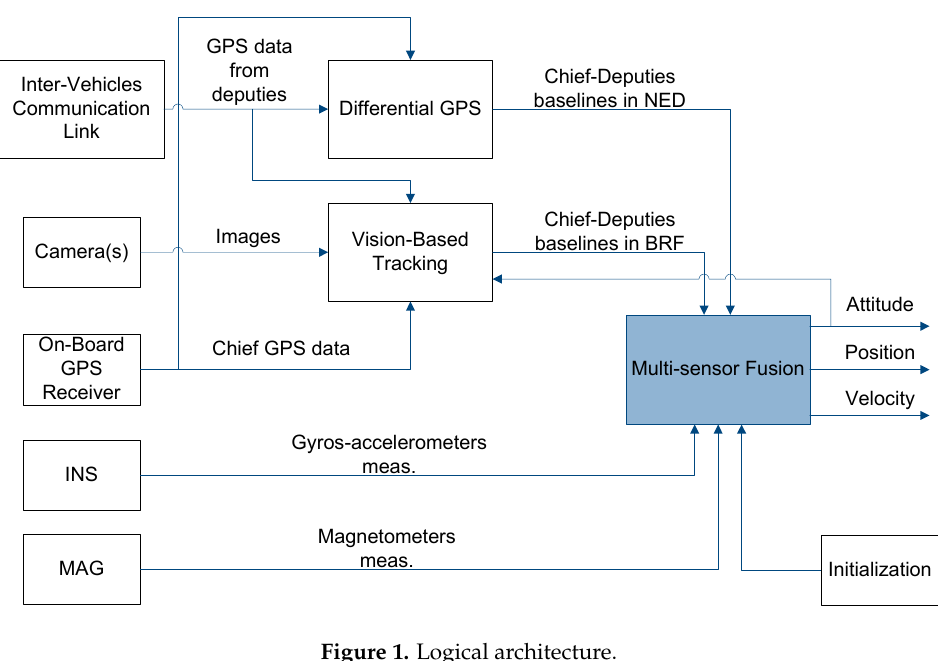
Figure 1. Logical architecture.